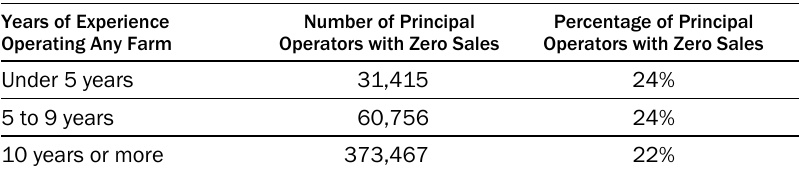
Table 3. Principal Operators with Zero Sales by Years of Experience, 2012